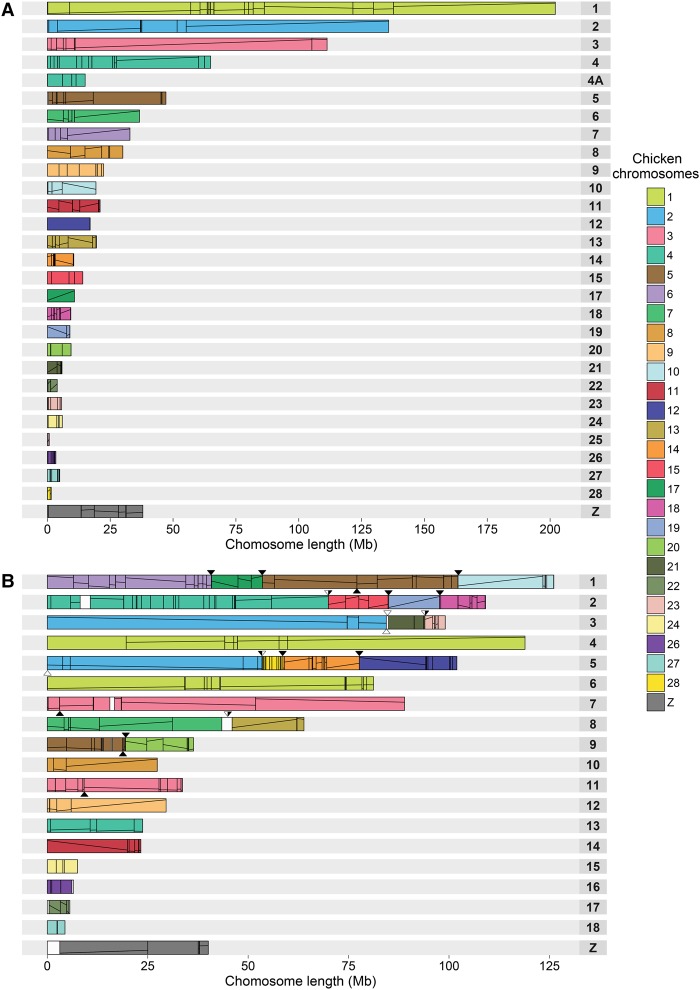
Ideogram of pigeon (A) and peregrine falcon (B) chromosomes. Numbered rectangles represent chromosomes, and colored blocks inside represent regions of homeology with chicken chromosomes. Lines within the colored blocks represent block orientation. Pigeon chromosomes 1–9 and Z were numbered according to the method of Hansmann et al. (2009) and the remaining chromosomes according to their chicken homeologs. Falcon chromosomes 1–13 and Z were numbered accordingly to the method of Nishida et al. (2008). The remaining chromosomes were numbered by decreasing combined length of the placed PCFs. Triangles above the falcon chromosomes point to the positions of falcon-specific fusions; below chromosomes, the positions of fissions. Black filling within the triangles point to the EBR boundaries used in the CNE analysis.